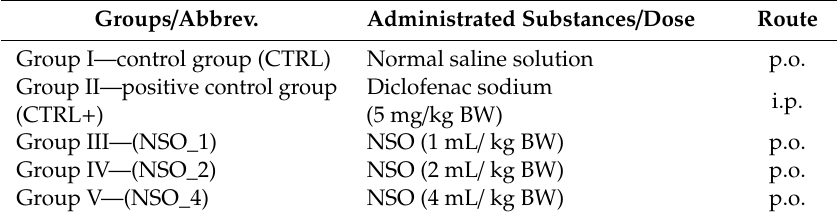
Table 1. Experimental design of carrageenan-induced acute inflammation. Groups /